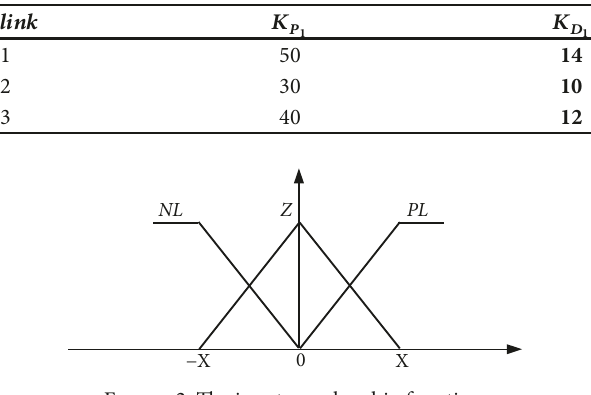
Figure 2: The input membership